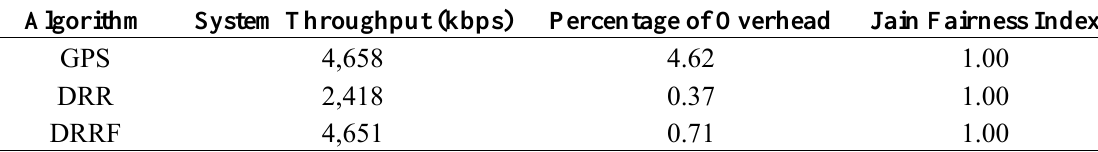
Table 6. System Throughput versus Percentage of Overheads